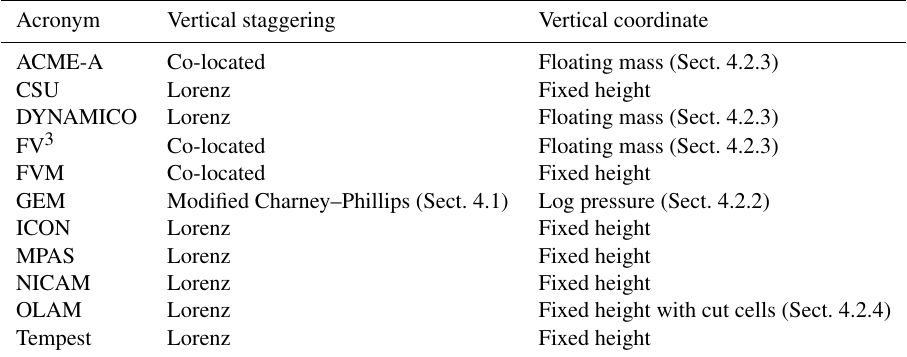
Table 4. Vertical staggering (detailed in Sect. 4.1) and vertical coordinates (detailed in Sect. 4.2) for participating dynamical cores.